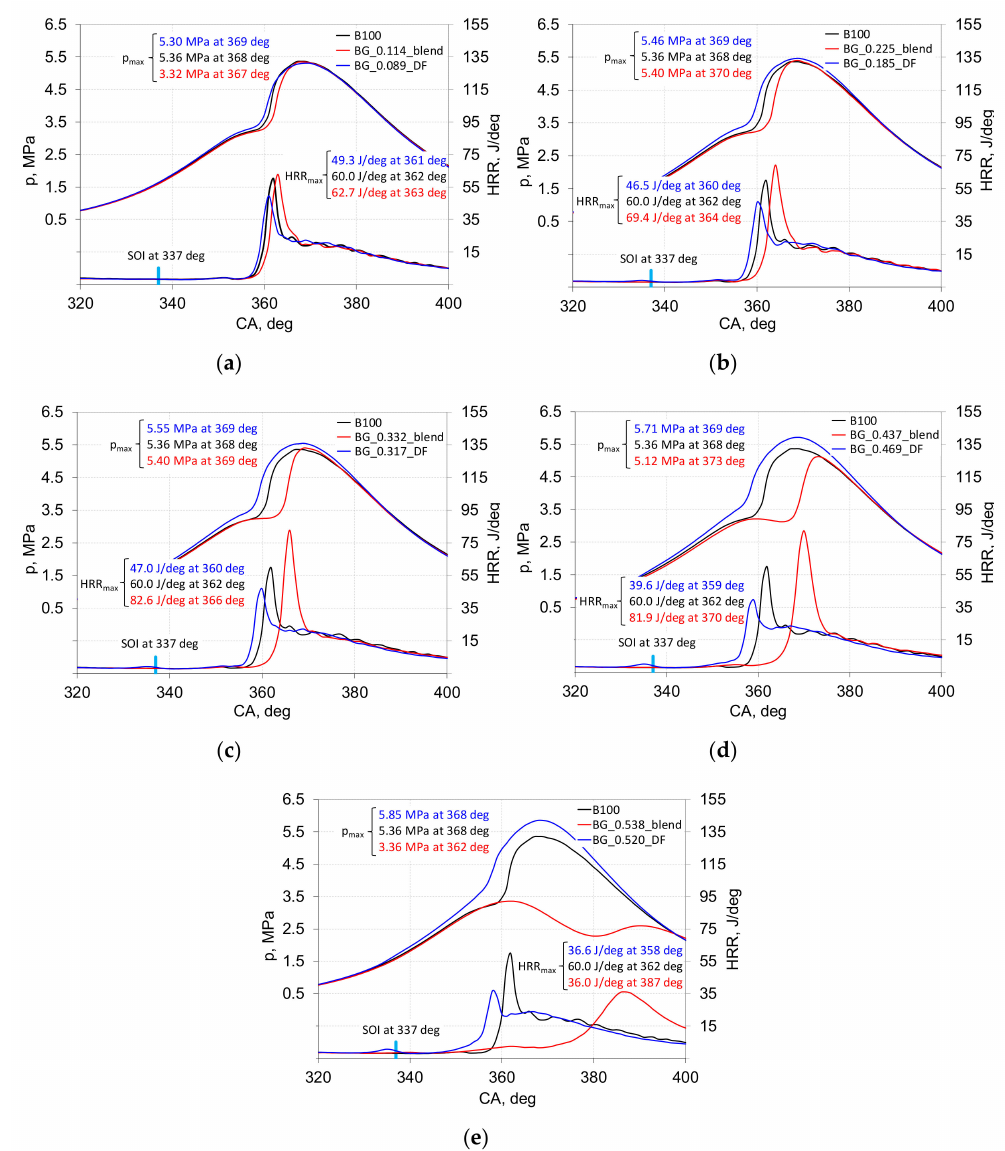
Figure 7. The impact of combustion mode on pressure and heat release rate in the case of biodiesel-gasoline combustion, ( a ) ~10% of gasoline, ( b ) ~20% of gasoline, ( c ) ~30% of gasoline, ( d ) ~40% of gasoline, ( e ) ~50% of gasoline.